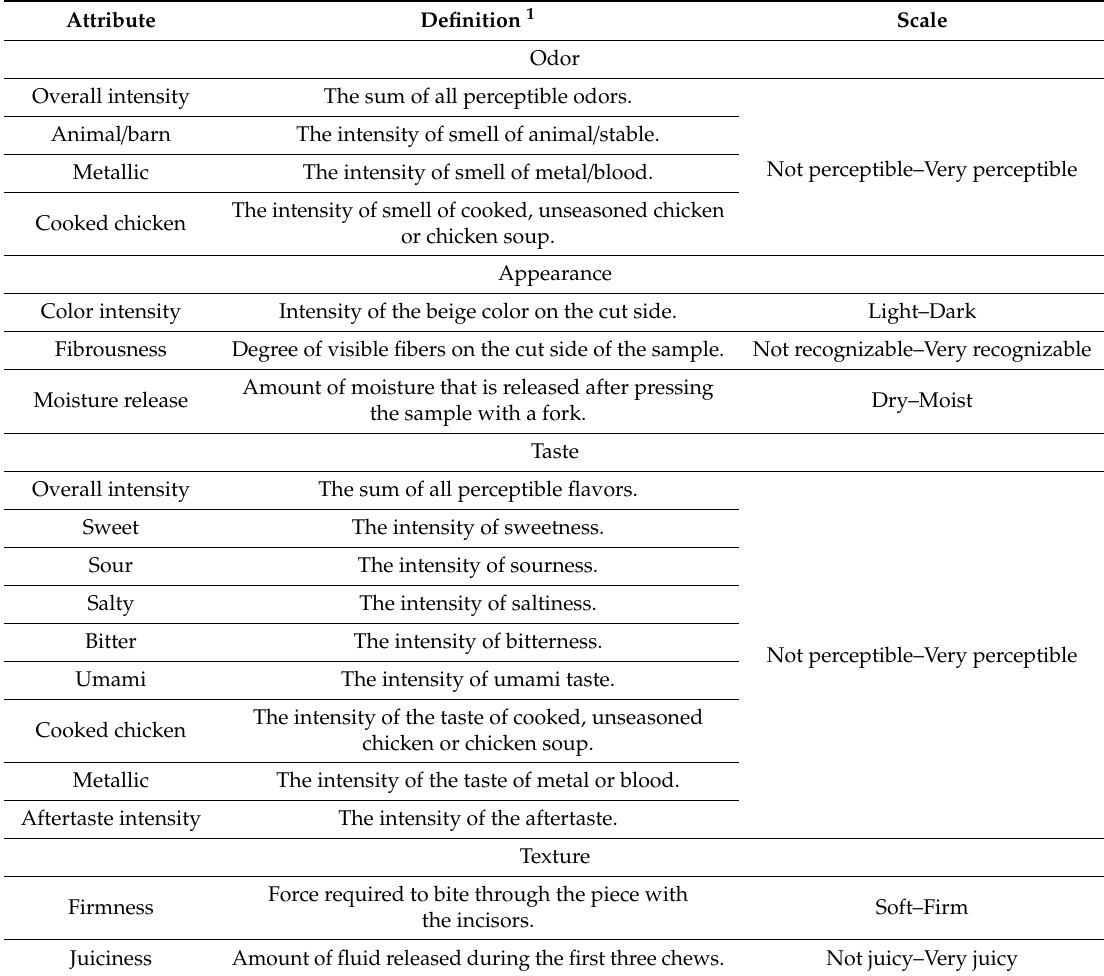
Table A1. Sensory attributes, definitions, and scales used to evaluate breast